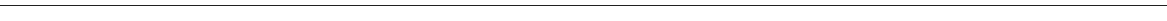
FIGURE 6 | indicated mice ( n = 3) were collected and sectioned when the volumes reached 2,000 mm 3 . (E) The tissues sections were stained with anti-CD8 antibody. The density of CD8 + T cells were quantified by Image J. Numbers in the panel indicate average values of three samples per group, quantified by Image J. (F) The TILs from DTT-neoAg-treated mice or PBS-treated mice were stimulated with CTB-neoAg (30 µ g/mL) for 72h, and were used as effector cells, then co-cultured with target cells B16F10 at indicated ratios for 4h at 37 ◦ C. The percentage of cell lysis was determined by LDH assay. (G) H&E staining of B16F10 tumor sections from indicated mice. Red arrows indicate the necrosis area, scale bar length is 100 µ m.